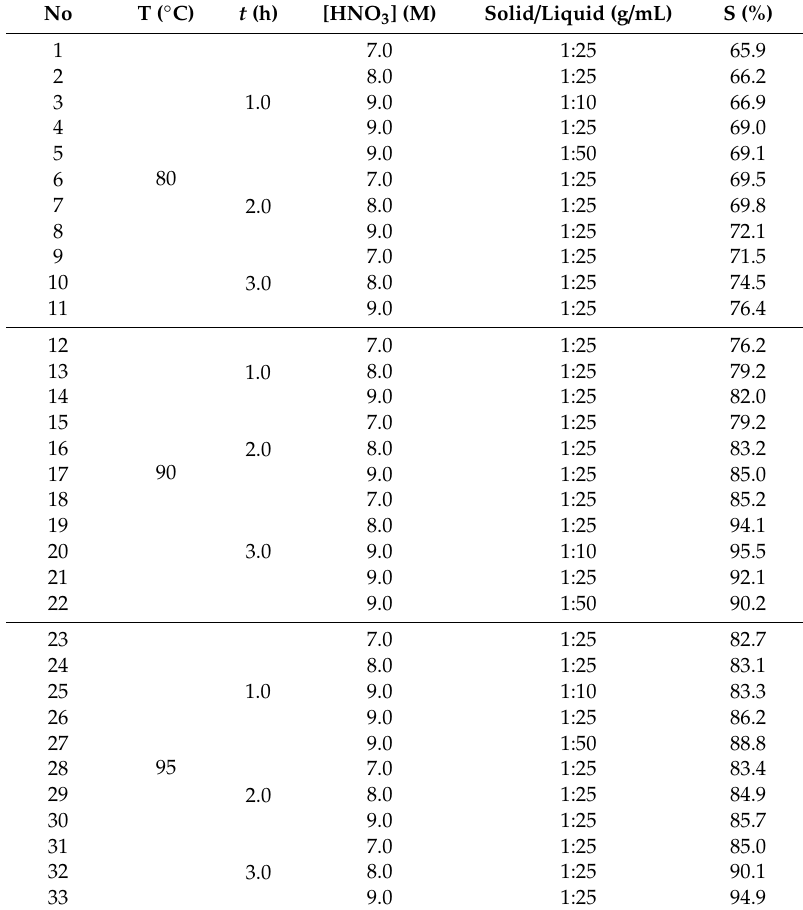
Table 4. The dependence of the solubility of precipitation of hydroxides of REEs, Th, U on the dissolution conditions. Sample weight 1 g.